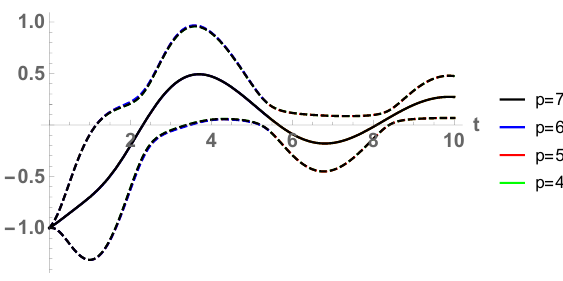
Figure 3: Expectation and confidence interval for the solution stochastic process, for orders of basis p = 4, 5, 6, 7 . Example 4.2, assuming independent random